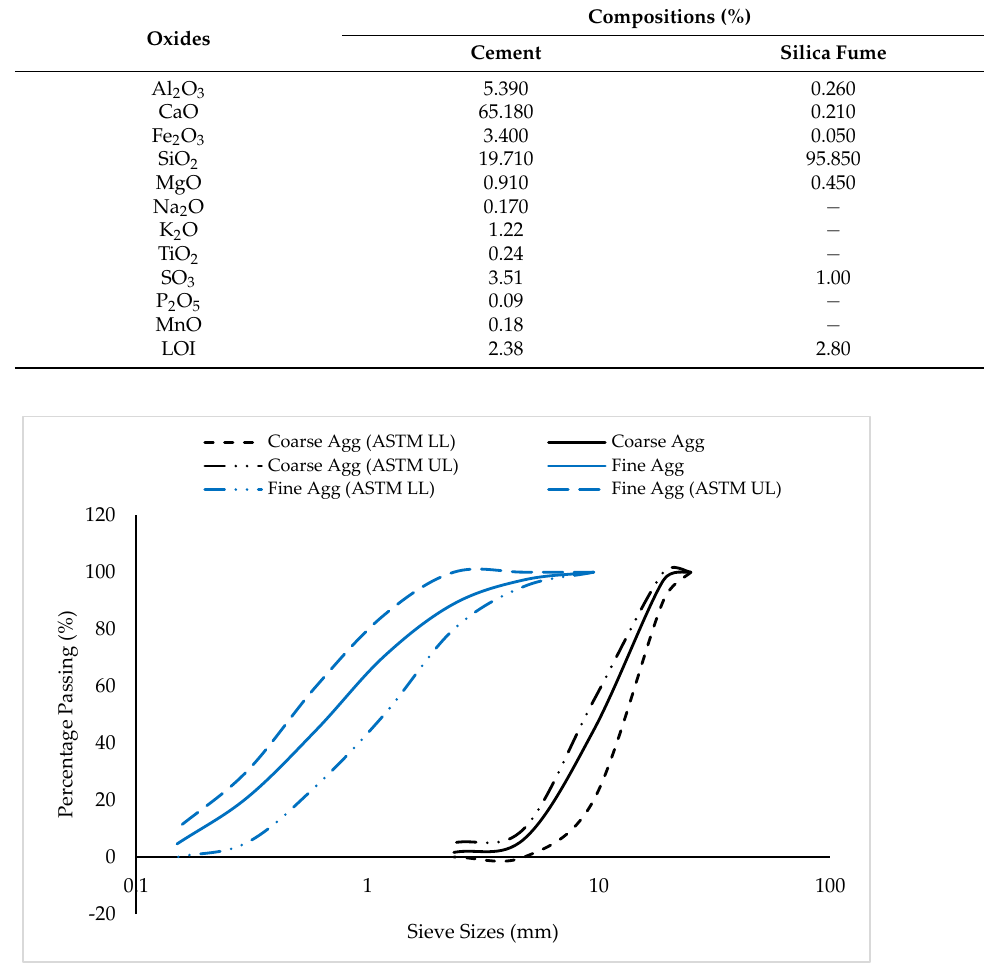
Figure 1. Particle-size distribution of aggregates.